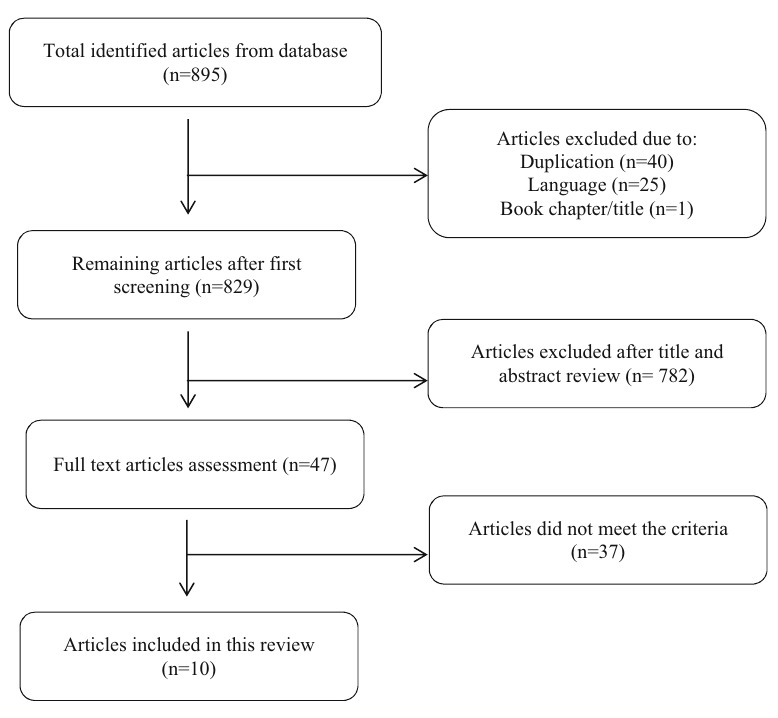
Figure 1. The flow diagram of the study selection.